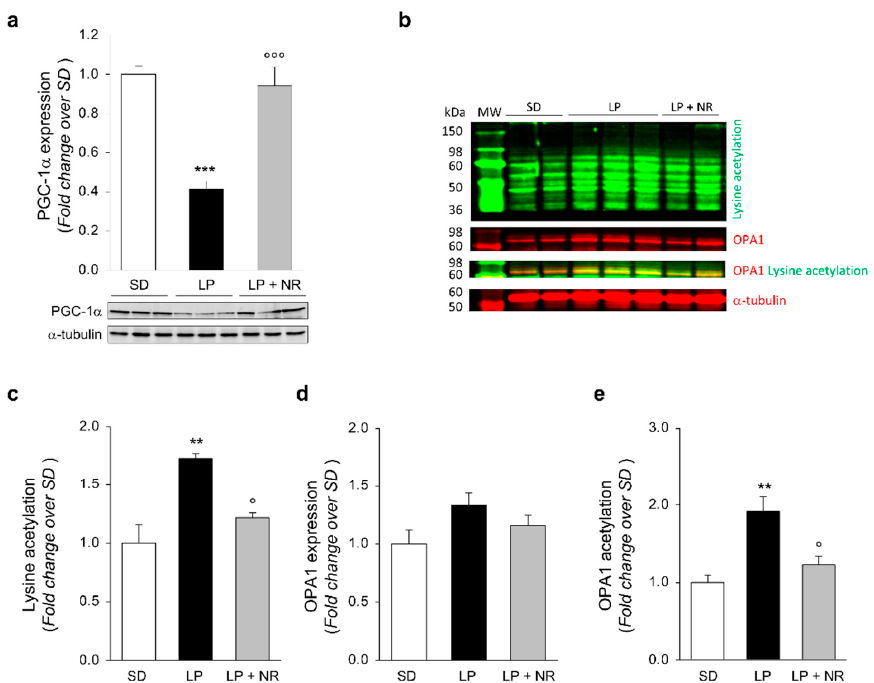
Figure 4. NR supplementation upregulates PGC-1 α in maternal LP diet offspring and normalizes hyperacetylation of mitochondrial proteins. ( a ) Representative Western Blots and densitometric analysis of PGC-1 α protein expression in total kidney extracts harvested from newborn mice (day 1) from mothers fed a SD, LP diet alone or with NR ( n = 7 samples per group). Each sample consisted of a pool of at least 4 kidneys from 4 newborn mice. ( b – e ) Representative Western Blots ( b ) and densitometric analysis of lysine acetylation ( c ), OPA1 expression ( d ), and OPA1 acetylation ( e ) in total kidney extracts harvested from newborn mice (day 1) from mothers fed with SD, LP diet alone or with NR ( n = 3 samples per group). Each sample consisted of a pool of at least 4 kidneys from 4 newborn mice. OPA1 acetylation has been evaluated as the colocalizing signal (yellow) between acetyl lysine (green) and OPA1 (red). In all gels, α -tubulin was used as a sample loading control. Results are presented as mean ± SEM and were analyzed with ANOVA with Tukey’s post hoc test. ** p < 0.01, and *** p < 0.001 vs. SD; ° p < 0.05, and °°° p < 0.001 vs. LP.